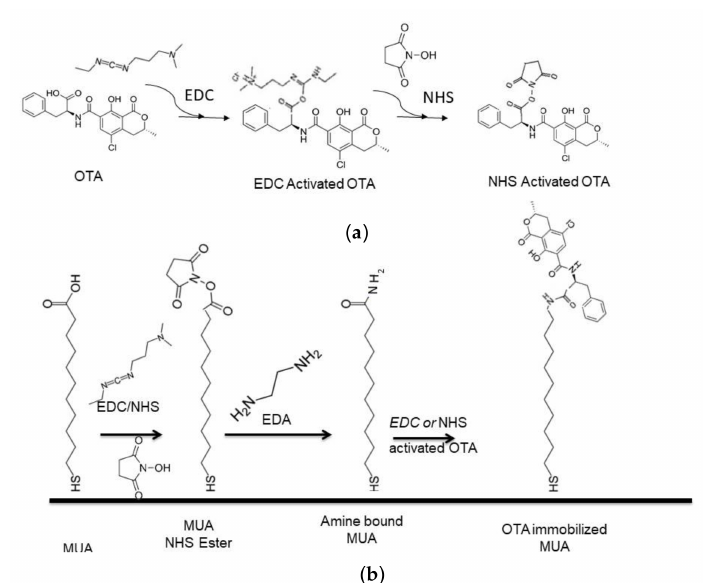
Figure 1. Schematic illustration of OTA immobilization to sensor surface. ( a ) OTA activation with EDC/NHS; and ( b ) immobilization of activated OTA to SAM coated sensor surface.